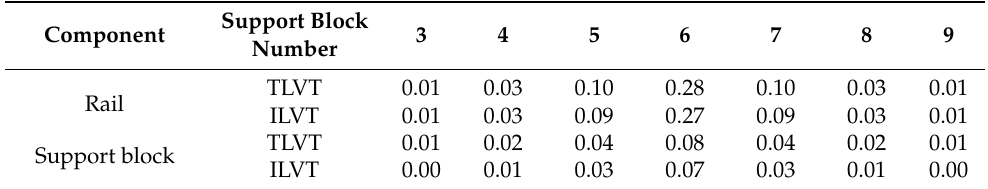
Table 2. Turnover angle of rail and support